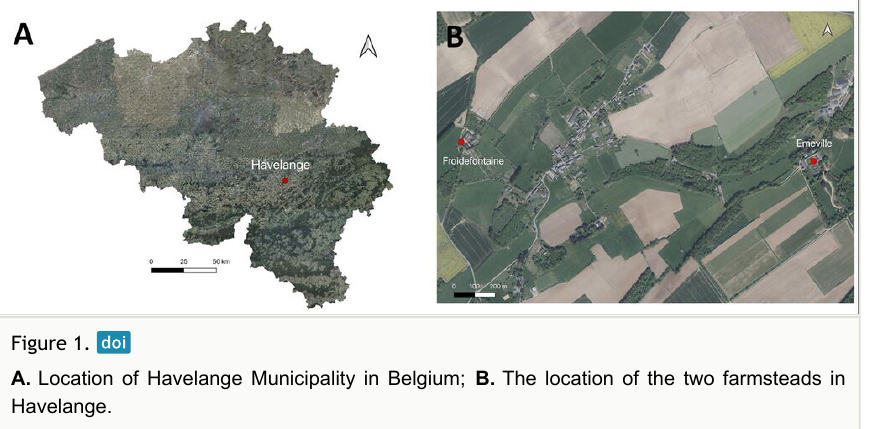
A. Location of Havelange Municipality in Belgium; B. The location of the two farmsteads